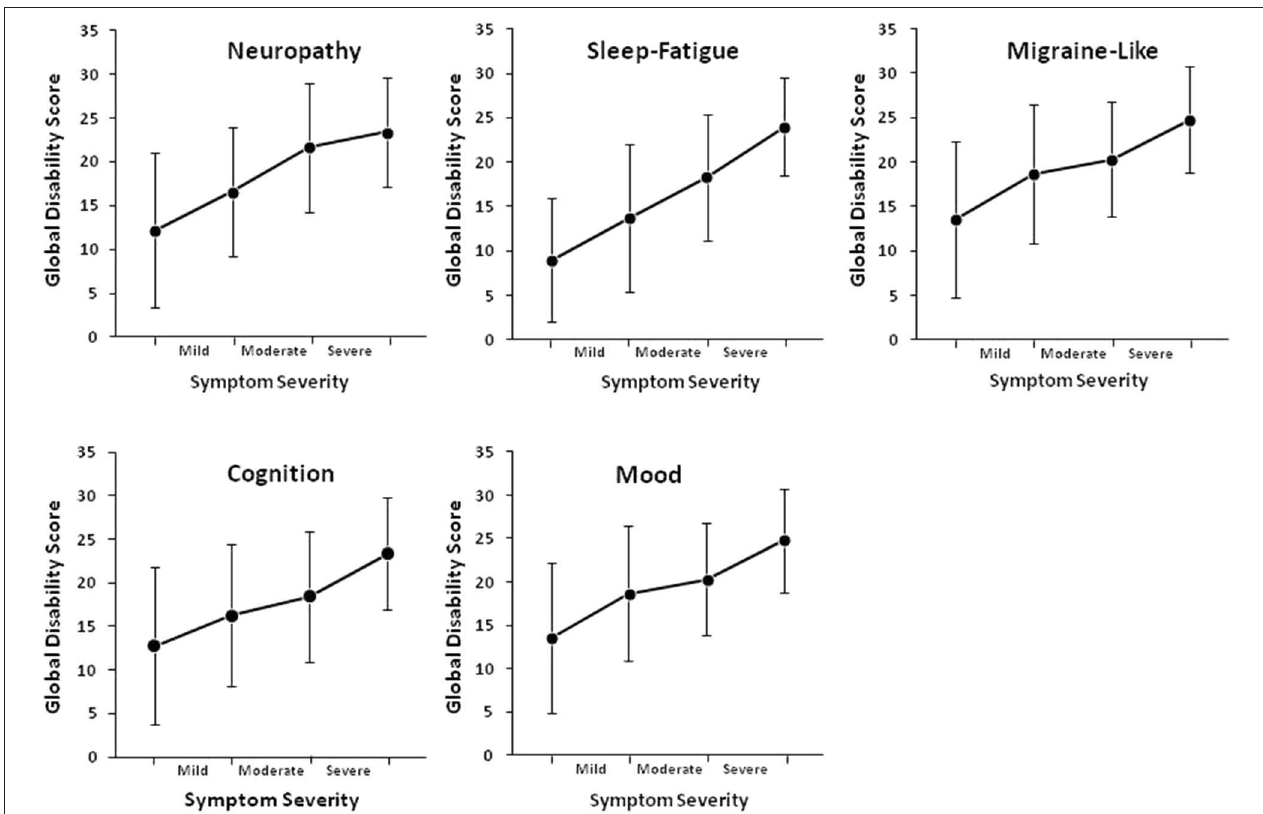
FIGURE 3 | Effect of increasing symptoms severity of functional